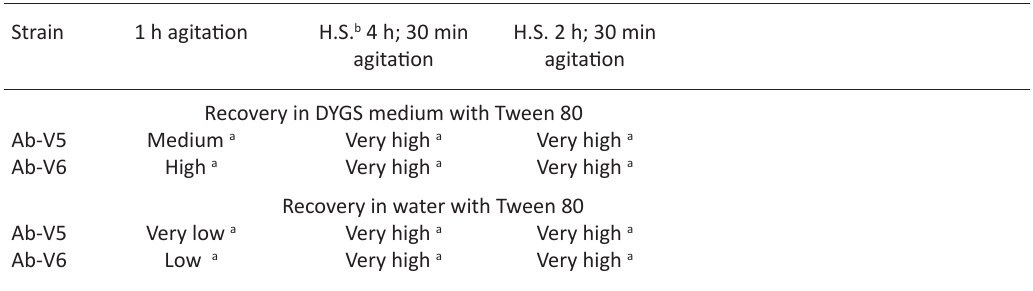
Table 2. Cellular recovery and cell counting a of Azospirillum brasilense from inoculated maize seeds using different diluents